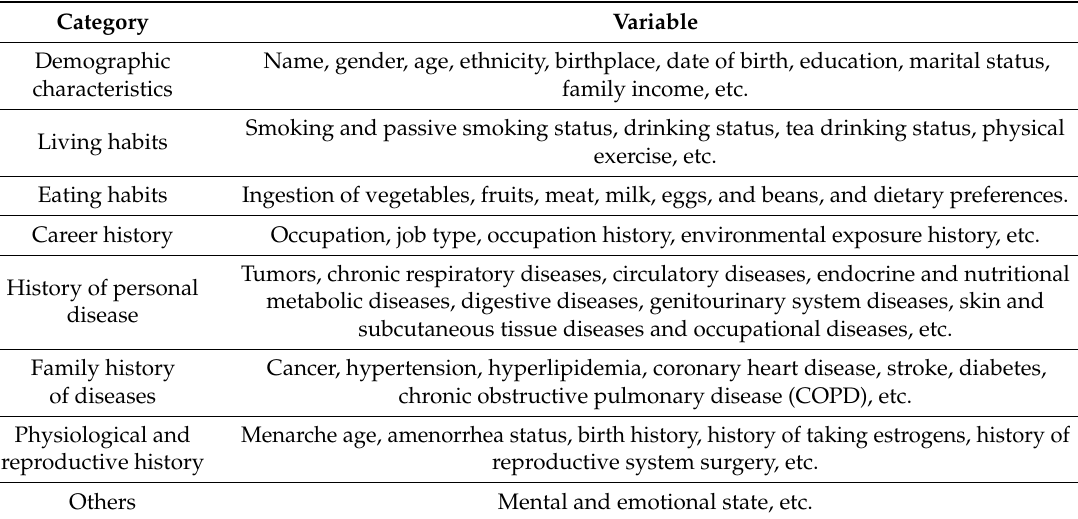
Table 1. Epidemiological Investigation Content of Jinchang Cohort